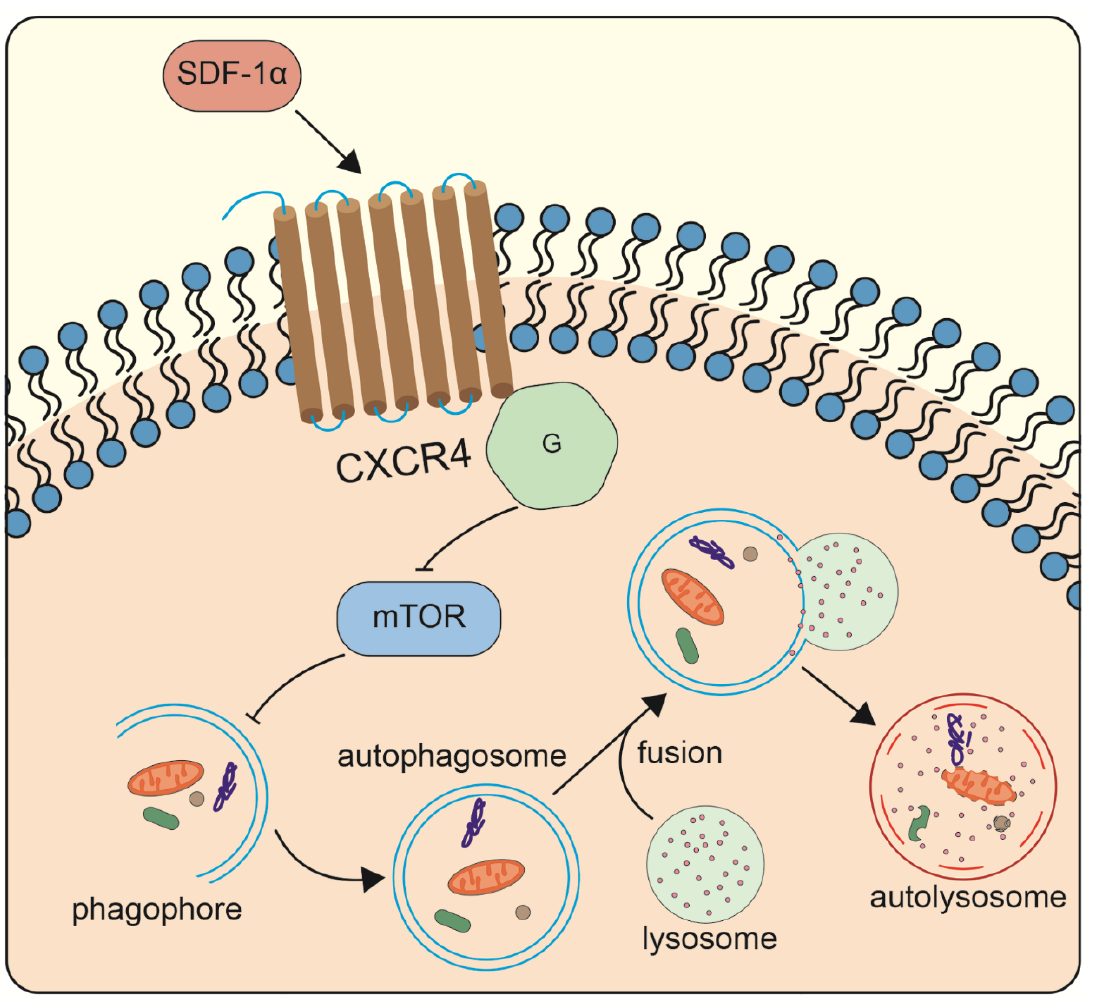
Figure 6. Diagrammatic sketch showing how SDF-1 α mediates autophagy in chondrocytes. SDF-1 activates the subsequent cytoplasmic signals by binding to CXCR4 on the chondrocyte membrane. These signals enter the chondrocytes then inhibit the phosphorylation of the mTOR signaling, and ultimately upregulate the autophagy